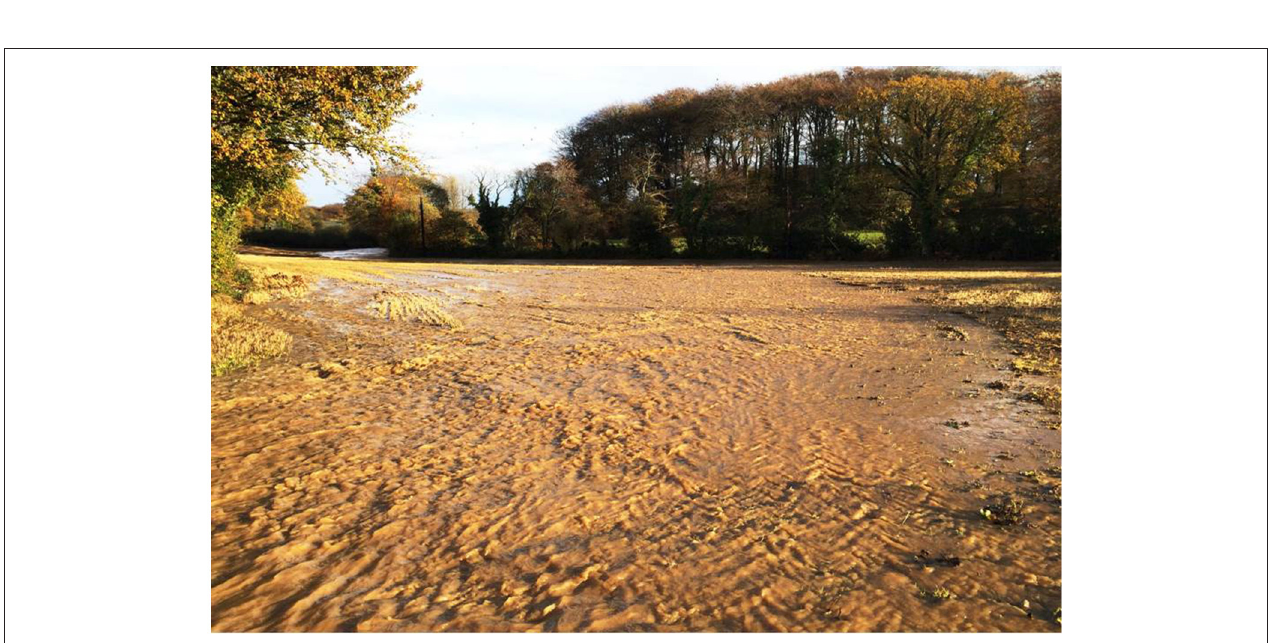
FIGURE 4 | Overland flow on an arable field with well drained soils (country Wexford, Ireland), following heavy rainfall in November 2014 [photo: Michael Fleming].